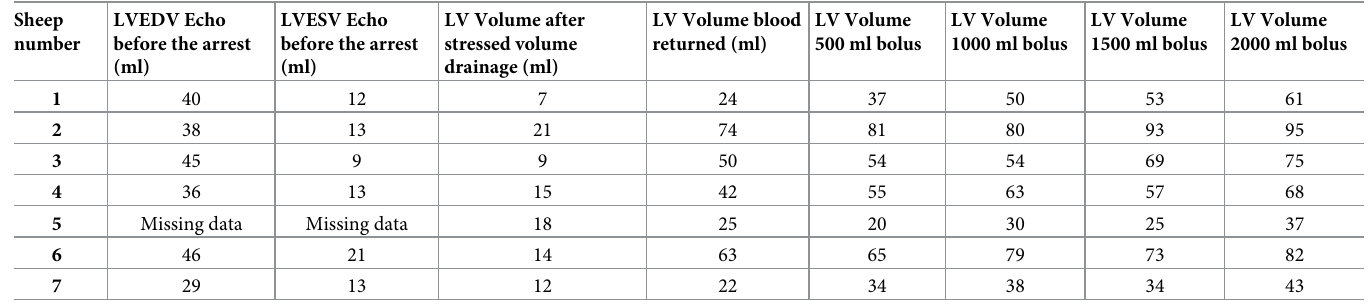
Table 4. Left ventricular volume measured with